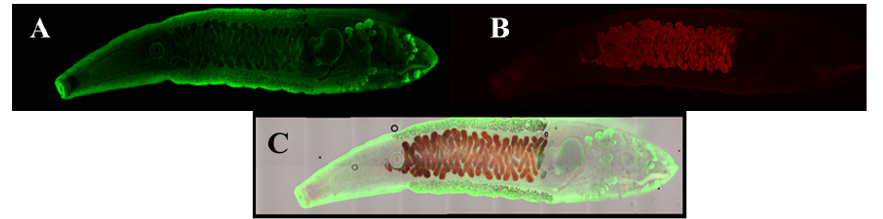
tary due to the nature of their potential commercial value.